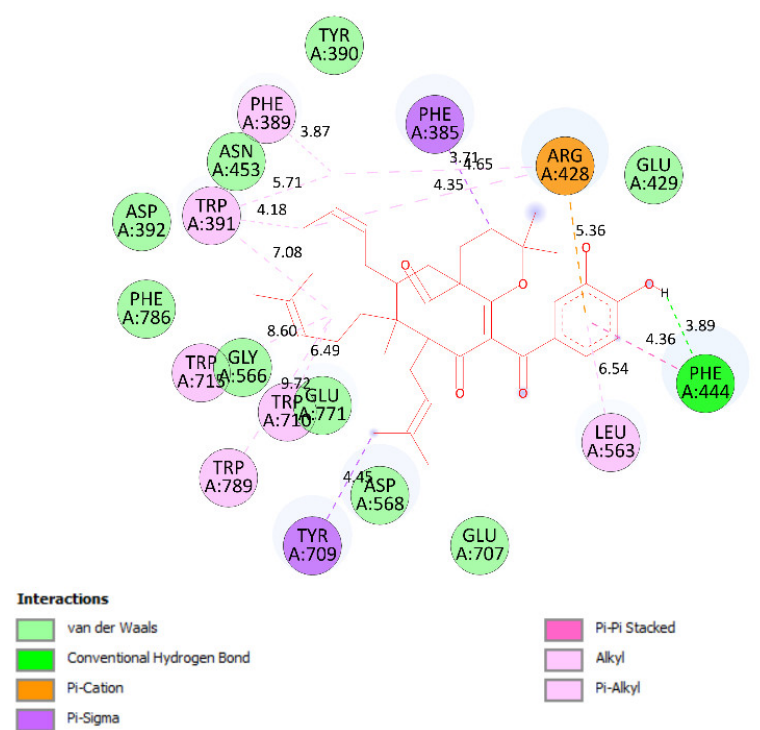
Figure 4. The most significant ligand interactions between compound 1, pose 148 and receptor 4J5T (PDB), a member of the α-glucosidase enzyme family.